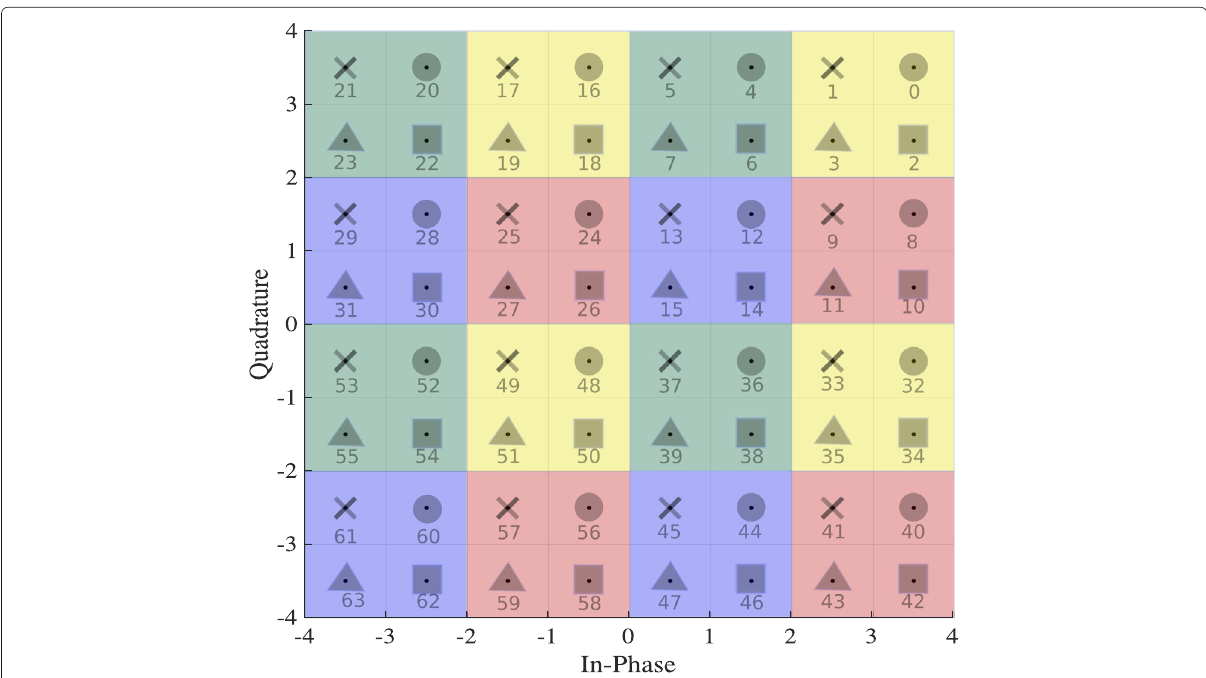
Fig. 10 Shaping regions mapping II for